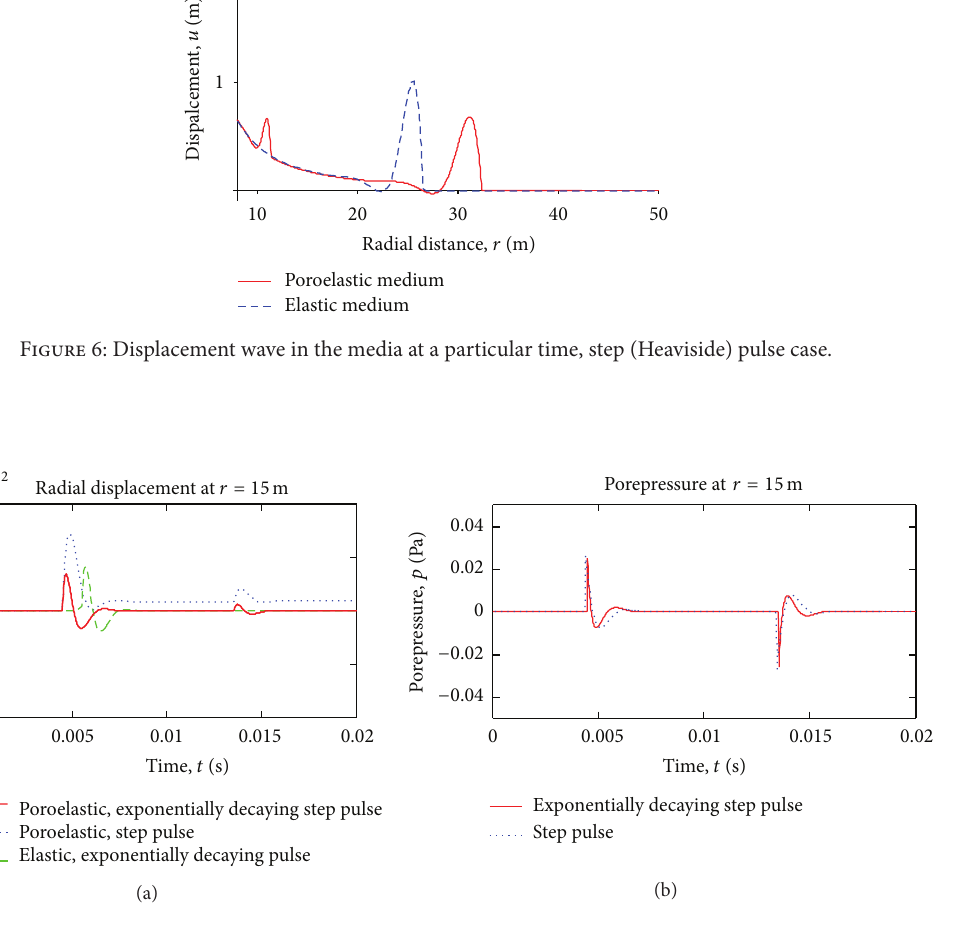
Figure 7: Time variation of radial displacement and pore pressure, exponentially decaying pulse